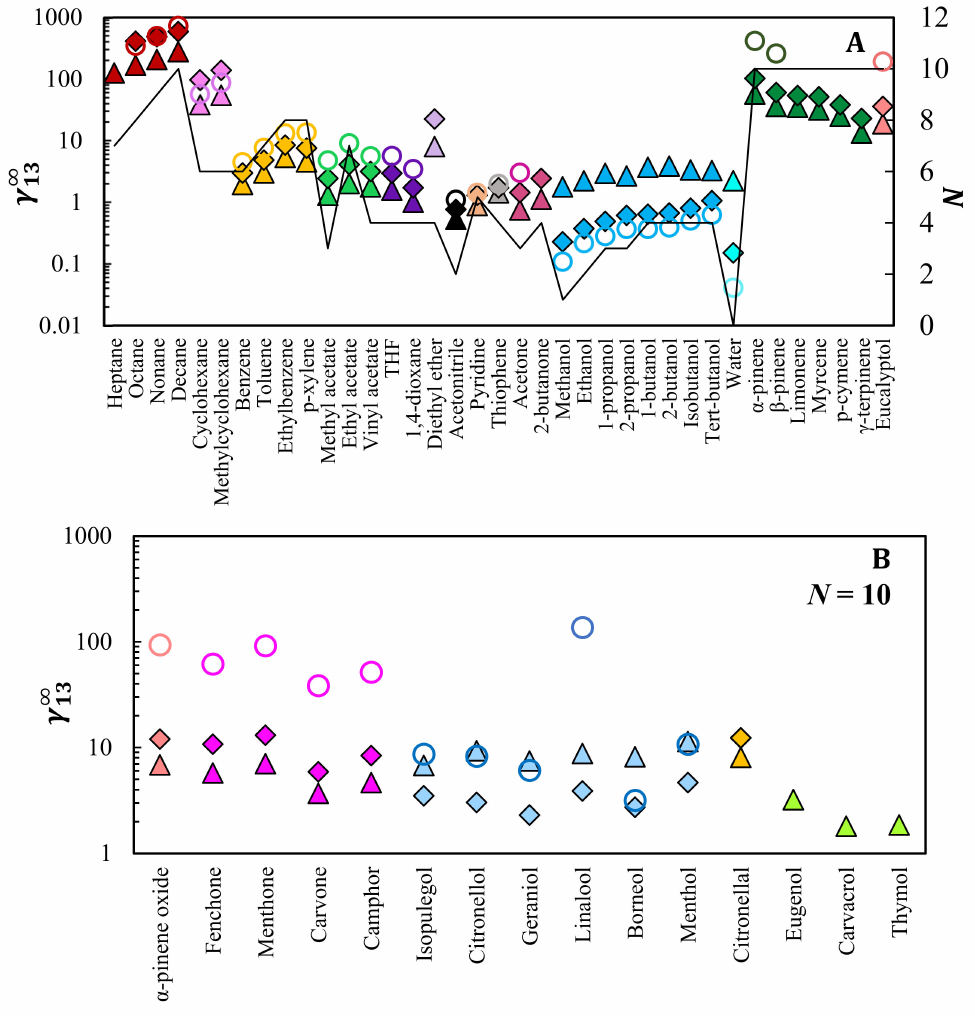
Figure 1. Activity coefficients at infinite dilution of several solutes in: ( (cid:7) ), [C 4 mim][PF 6 ]/[C 4 mim]Cl equimolar mixture; ( (cid:78) ), [C 4 mim][PF 6 ]; ( ), [C 4 mim]Cl (from literature) [16,25]. Top panel, ( A ): (cid:35) traditional organic solutes, water, and some terpenes/terpenoids at 353.2 K. Bottom panel, ( B ): less volatile terpenoids at 413.2 K. Symbols with different colors represent different chemical families while the solid line indicates the number of carbons ( N ) present in each solute. On the bottom panel, all solutes have 10 carbon